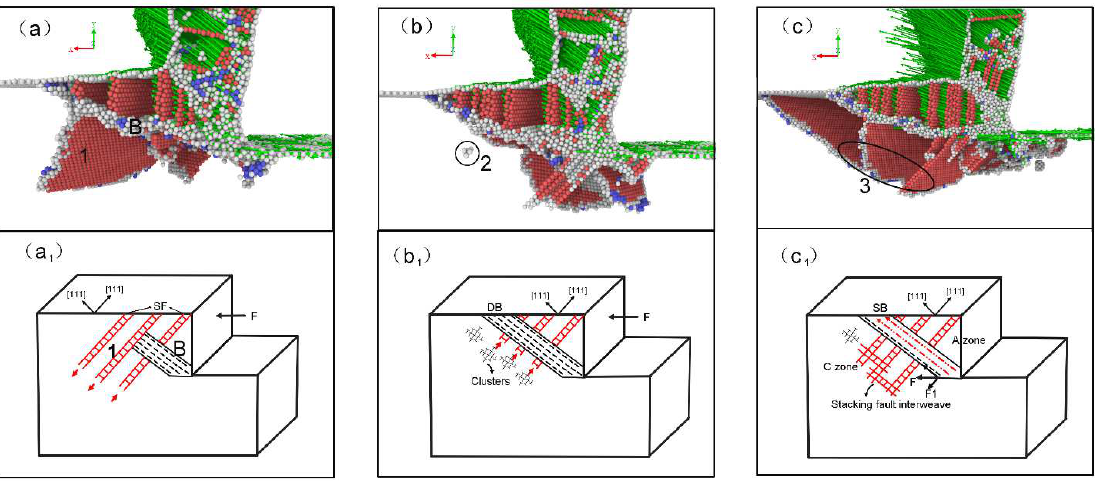
Figure 14. Slip channel formation process. ( a ) Defect displacement diagram; and ( b ) schematic diagram. ( a 1 – c 1 ) is the schematic diagram diagram corresponding to ( a – c ).